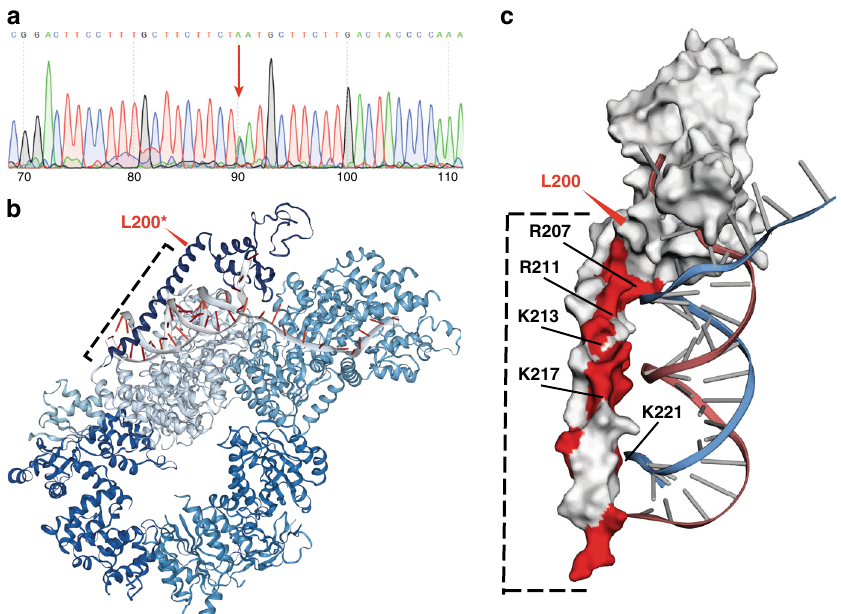
Fig. 4 L200* eliminates the DNA-binding domain of XPA. a Sanger sequencing of germline DNA con fi rms the L200* pDGV in XPA . b The cryo-EM structure of the XPA-TFIIH complex showing the interaction between XPA and DNA during nucleotide excision repair 23 . The L200* pDGV (red arrow) eliminates the entire alpha-helix of the DNA binding domain (dotted line). c The L200* pDGV (red arrow) eliminates the positively charged amino acid residues (red) which bind to the negatively charged DNA backbone. These positively charged amino acid residues (arrows), such as R207, are commonly affected by germline mutations in xeroderma pigmentosum